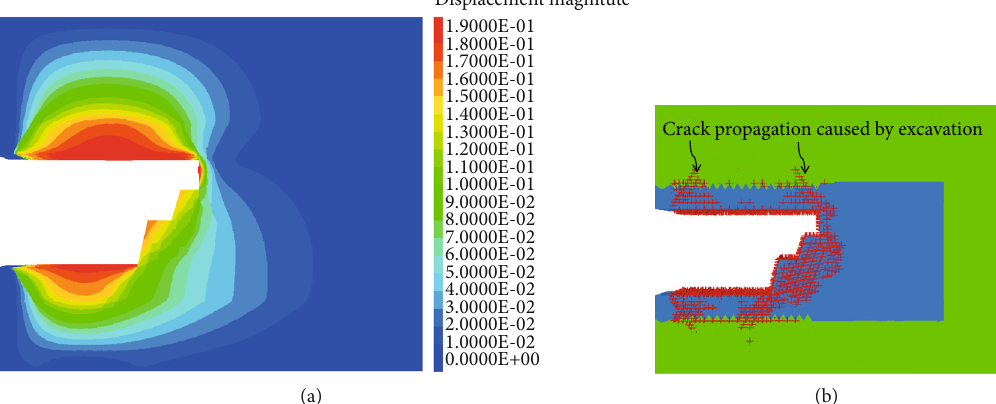
Figure 5: Tunnel displacement and crack propagation when safety thickness is 3m. (a) Displacement nephogram. (b) Fracture fi eld distribution.